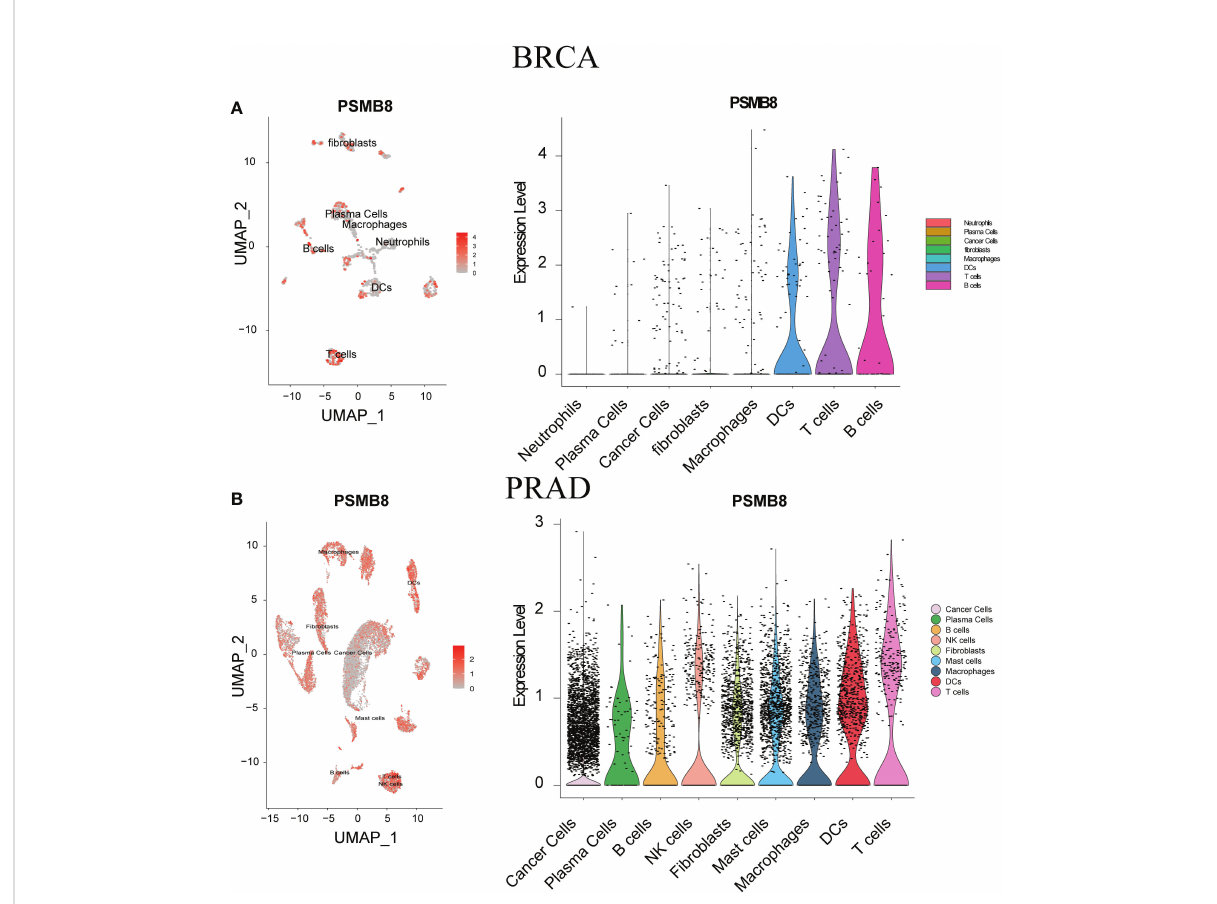
FIGURE 4 ScRNA-seq was used to show tumour cell localisation, cell classi fi cation and PSMB8 expression distribution. (A) The scRNA-seq results of PSMB8 expression in BLCA. (B) The scRNA-seq results of PSMB8 expression in